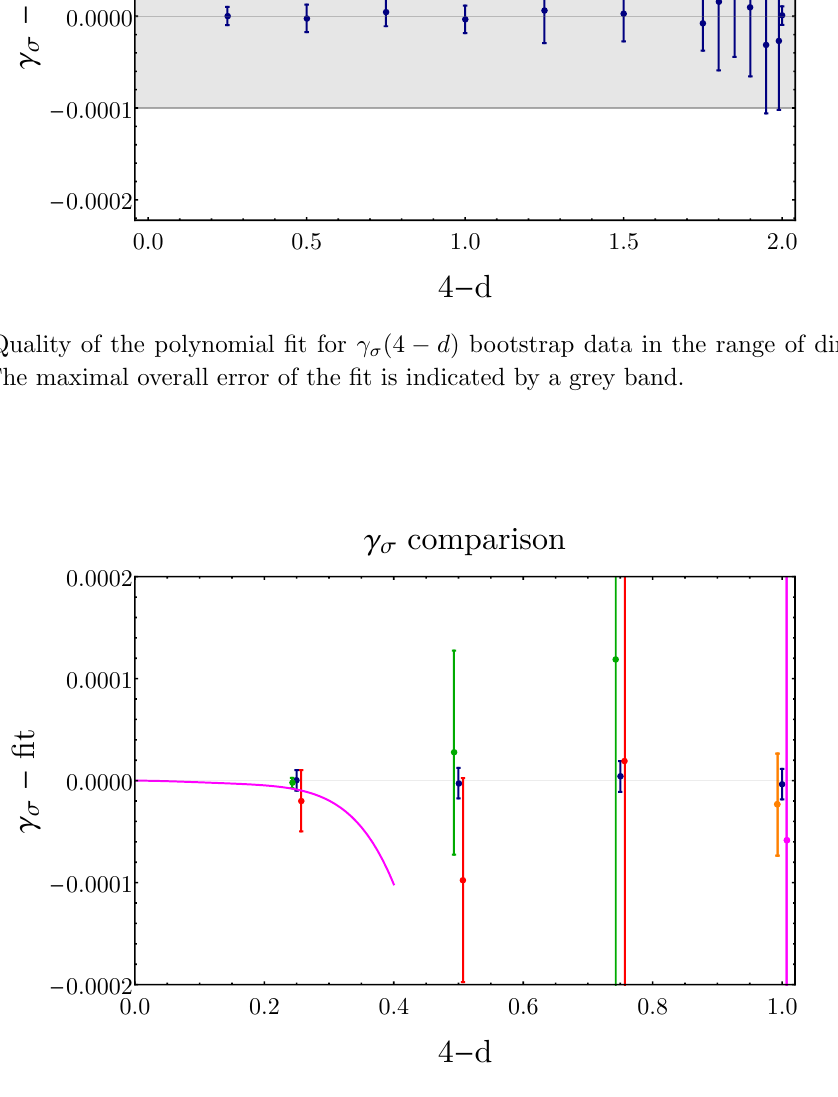
Figure 5 . Comparison of (cid:13) (cid:27) bootstrap data (blue) with: i) Borel-resummed epsilon expansion (green) [15, 16] and ii) 3-correlator bootstrap data (red) [8] for d = 3 : 75 ; 3 ; 5 ; 3 : 25 (the d = 3 coarse data are omitted); iii) unresummed high-order epsilon expansion and resummed estimate at d = 3 (magenta) [17] iv) Monte Carlo data at d = 3 (orange) [18] (Note that data points are slightly displaced around the same d value for improving